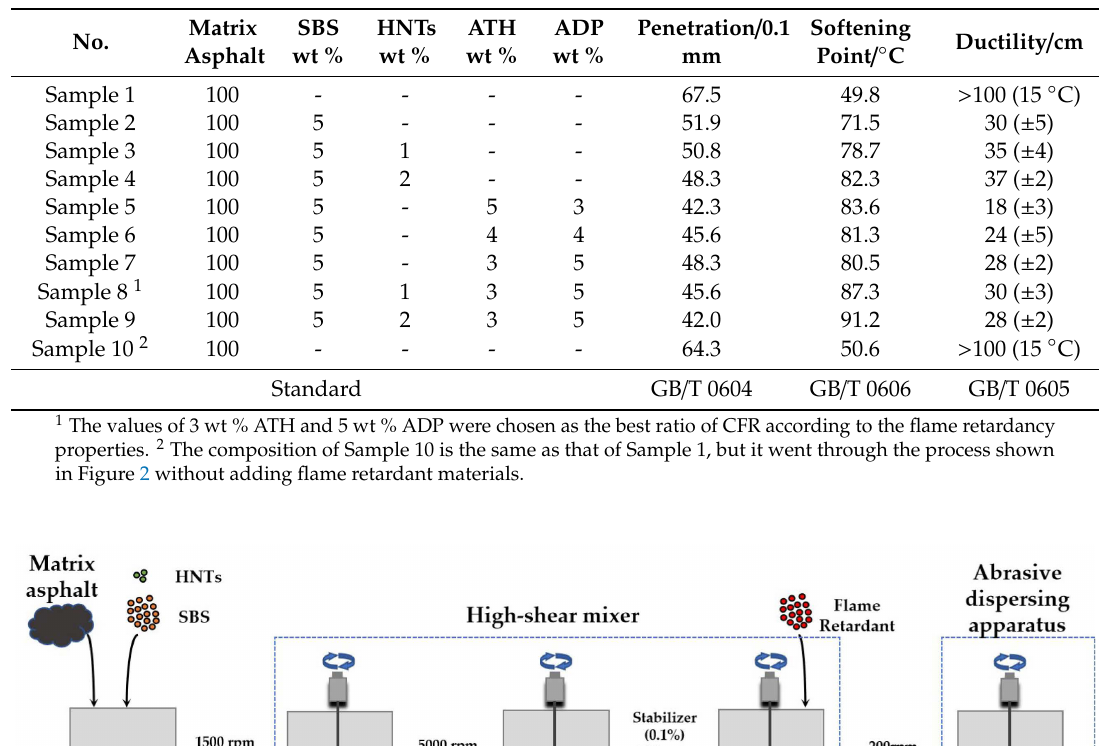
Table 1. Composition and physical properties of composite flame-retardant-modified asphalt binder.